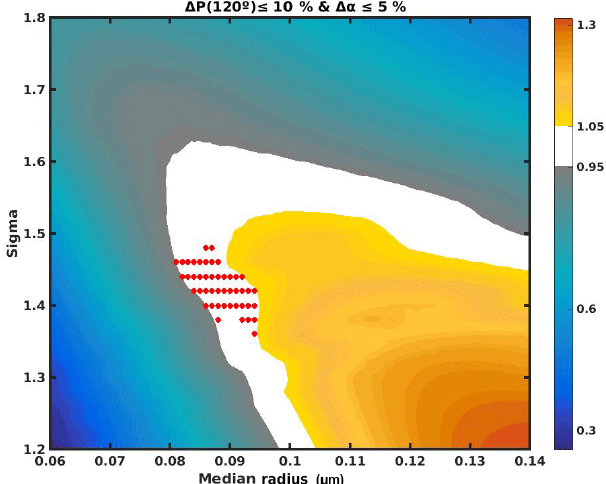
Figure 22. Identical to Fig. 21 except that the aerosol phase function comparison is done for (cid:50) = 120 ◦ . For this viewing geometry, the aerosol phase function criterion is much more useful in determining the aerosol size distribution properties: Note the smaller number of red circles (relative to Fig. 21), centered around the true values of r 1 (0.09µm) and σ 1